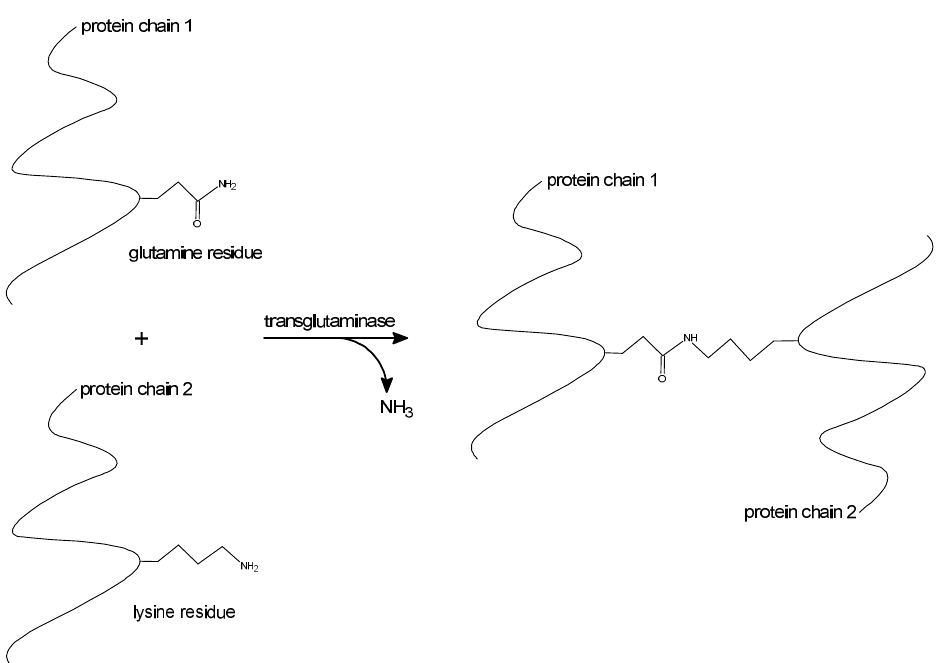
Figure 5. Cross-linking reaction of protein chains catalyzed by the enzyme transglutaminase. Modified from the work of [13].